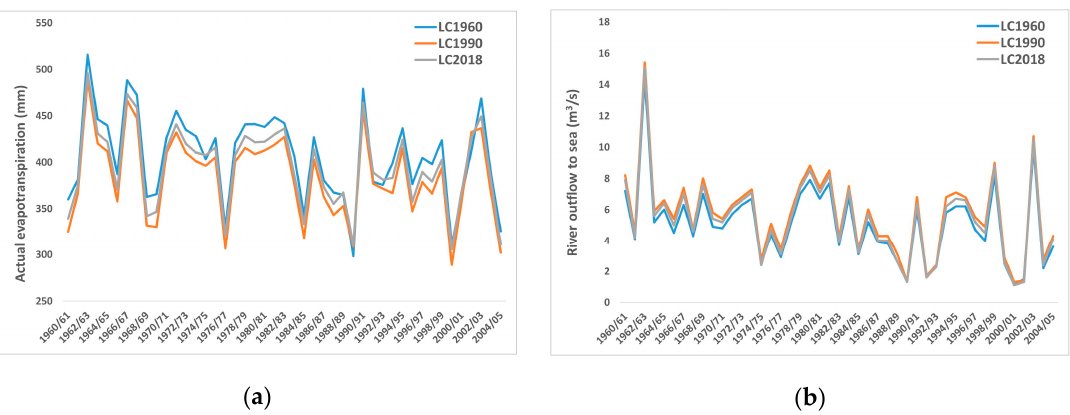
Figure 7. Basin-averaged annual actual evapotranspiration (mm) ( a ) and river discharge (m 3 / s) to Maliakos Gulf ( b ) reconstructions. LC1960, LC1990 and LC2018 are represented by blue, orange and gray lines.